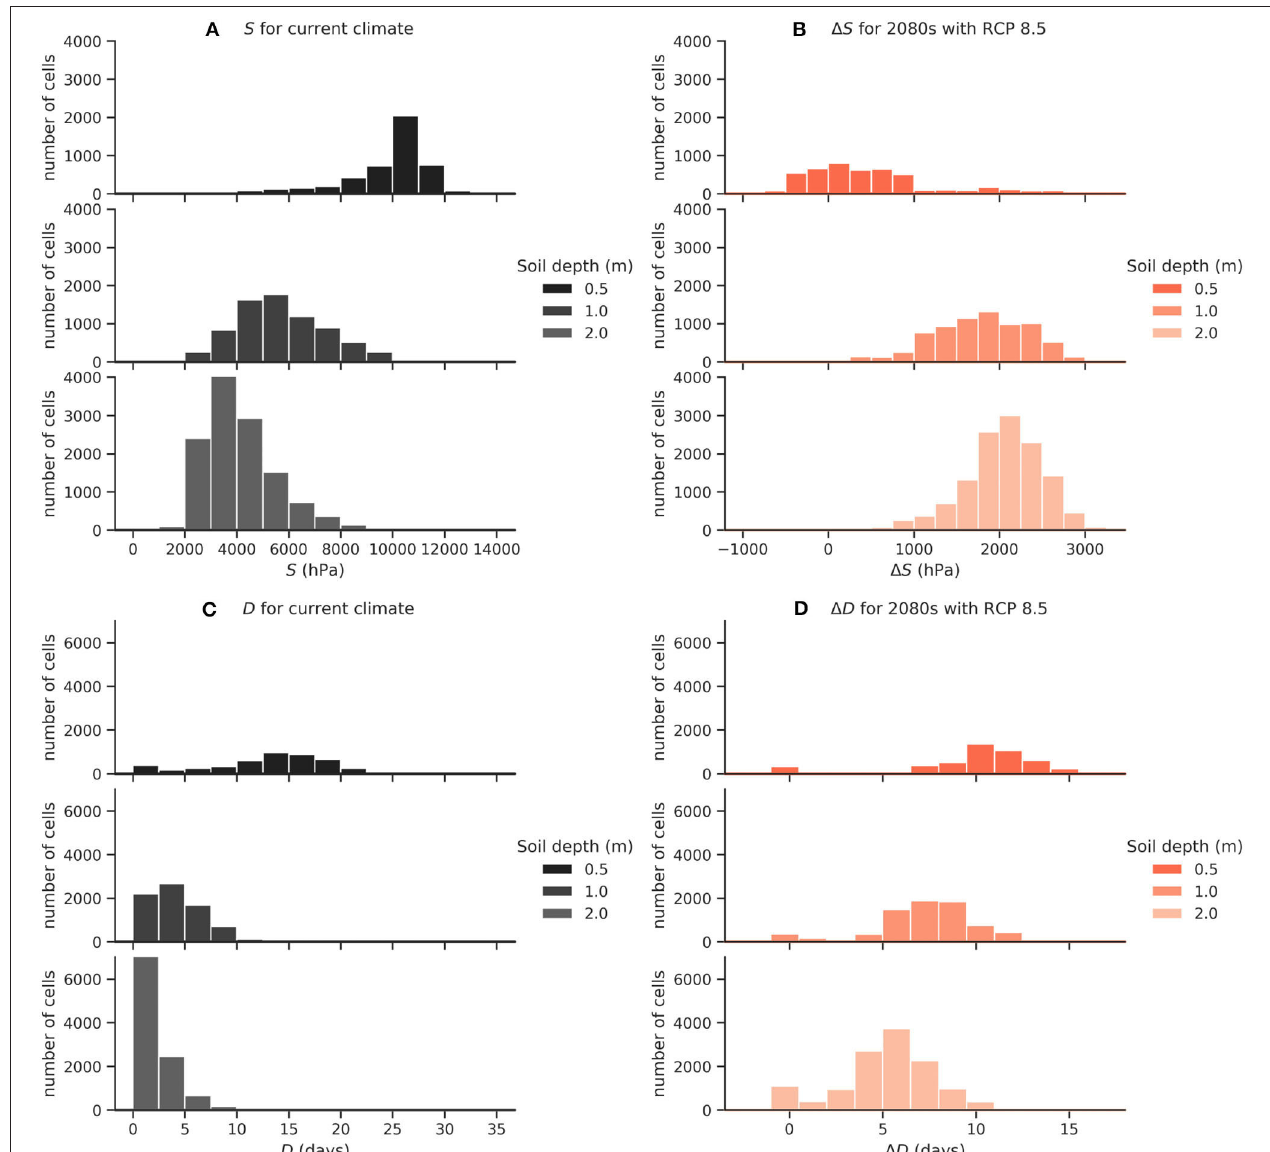
FIGURE 4 | Frequency distribution for the growing season (MJJASO) of (A) the severity S for current climate conditions (1981–2010), (B) the projected changes in the severity 1 S for 2080s (2071–2100) with RCP8.5, (C) the duration D for current climate conditions (1981–2010) and (D) the projected changes in the duration 1 D for 2080s (2071–2100) with RCP8.5 computed for the three soil depth